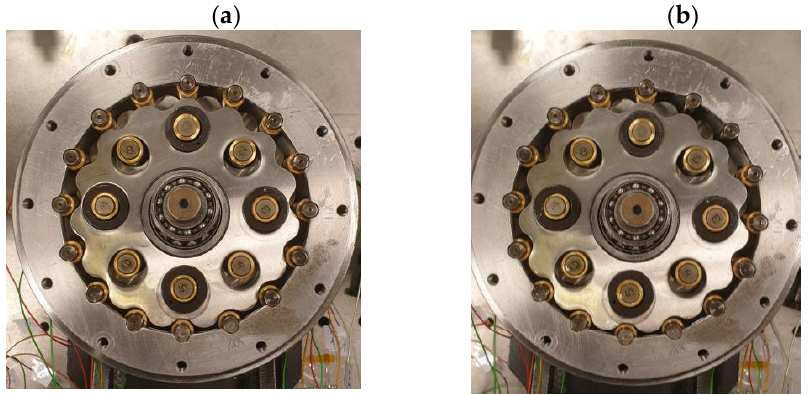
Figure 4. Cycloidal gear ( a ) complete (fault-free), ( b ) with the sliding sleeves removed on the two adjacent outer pins (faulty).